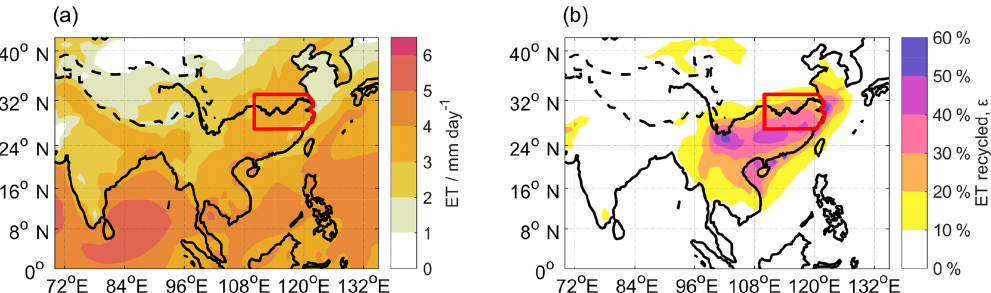
Figure 7. Evapotranspiration (a) and (cid:15) , the fraction of evapotranspiration resulting as YRV precipitation (b) . The values are the April– September, 1980–2016 means. ET data are from ERA-Interim and in millimeters per day (mmd − 1 ), while (cid:15) is a combination of WaterSip results and ET.